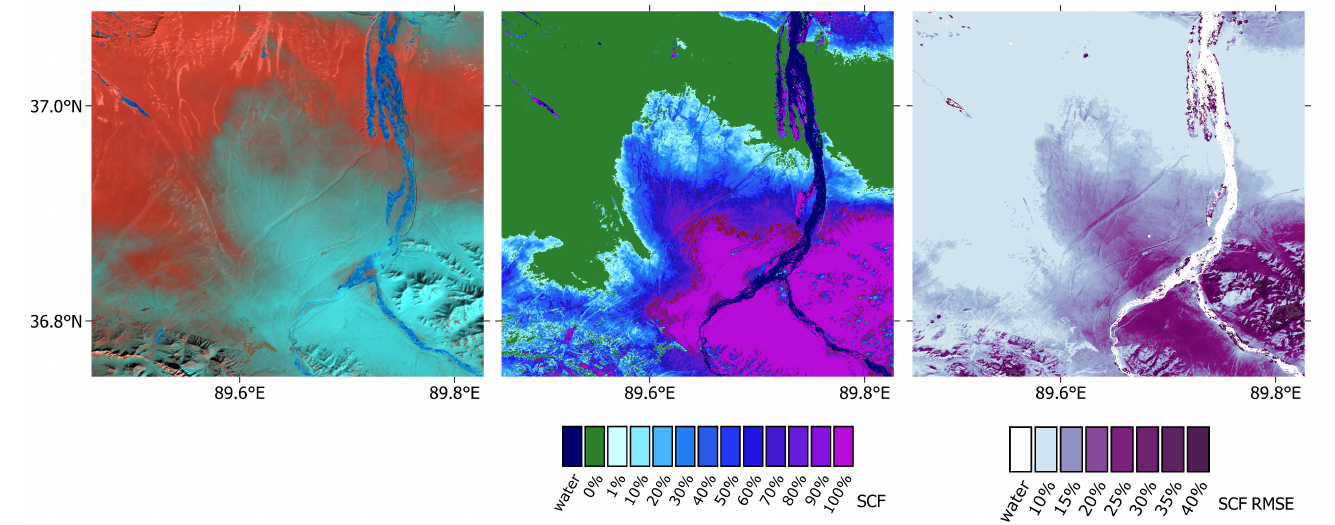
Figure 8. ( Left ): Landsat 9 OLI-2 false colour composite (bands 6, 5 and 3) near the Northern boundary of the Tibetan plateau (South of the Kunlun mountains) taken on 18 January 2022 (path 140, row 034). ( Center ): LAMSU SCF derived from Landsat 9 OLI-2 data at 30 m resolution. ( Right ): LAMSU SCF RMSE at 30 m resolution. Water mask source: EC